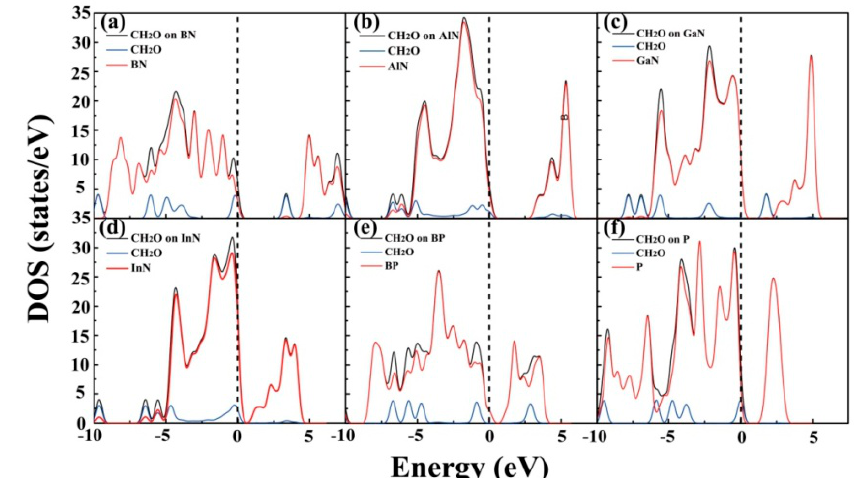
Figure 4. Density of states (DOSs) of CH 2 O on the surface of the ( a ) BN, ( b ) AlN, ( c ) GaN, ( d ) InN, ( e ) BP, and ( f ) P monolayers.